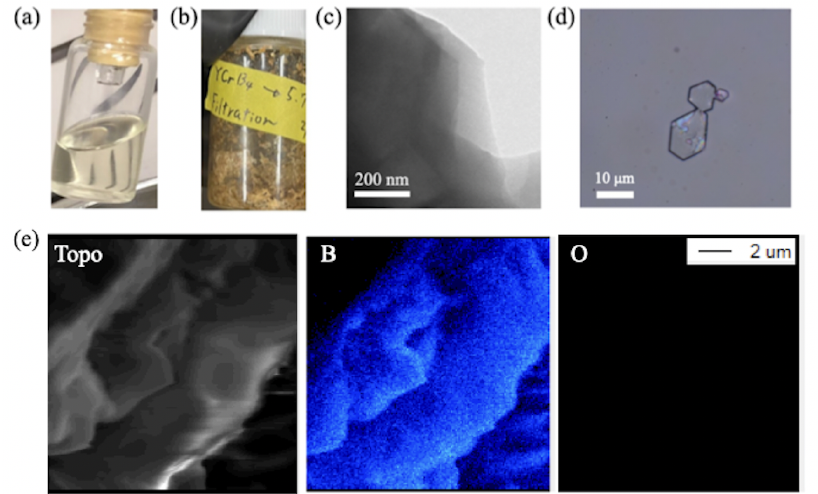
Figure 3. ( a ) A photo of the filtrate sample, synthesized by the addition of 1 mL HCl; ( b ) a photo of the powder sample after the drying treatment of ( a ); ( c ) an optical microscopy image of the single HB flake obtained after spin-coating of ( a ); ( d ) TEM images of the powder sample of ( b ). ( e ) SEM-EPMA images of the topographic (Topo) map and elemental maps of boron (B) and oxygen (O) of the HB